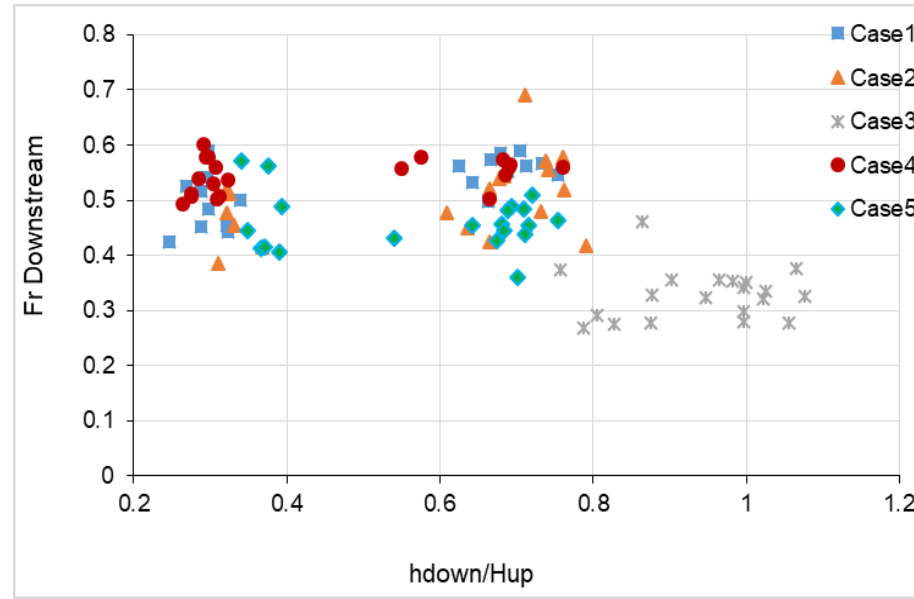
Figure 4. Relation between downstream Froude number and water depth ratio